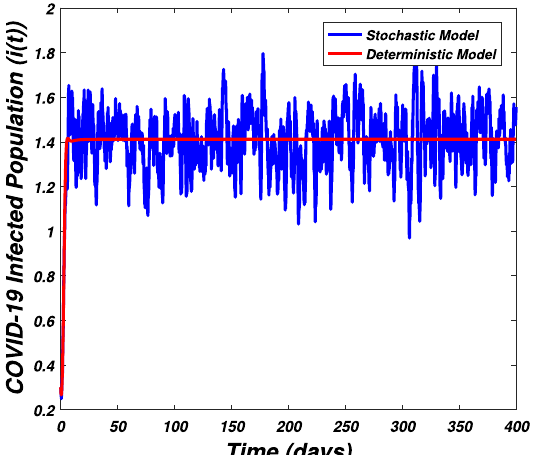
Figure 11. The graph visualizes the persistence of the epidemic problem framed by model (1) for the infected class ( i ( t )) against parameters value taken from S 2 and various sizes of initial population (0.5, 0.3, 0.2, 0.1).